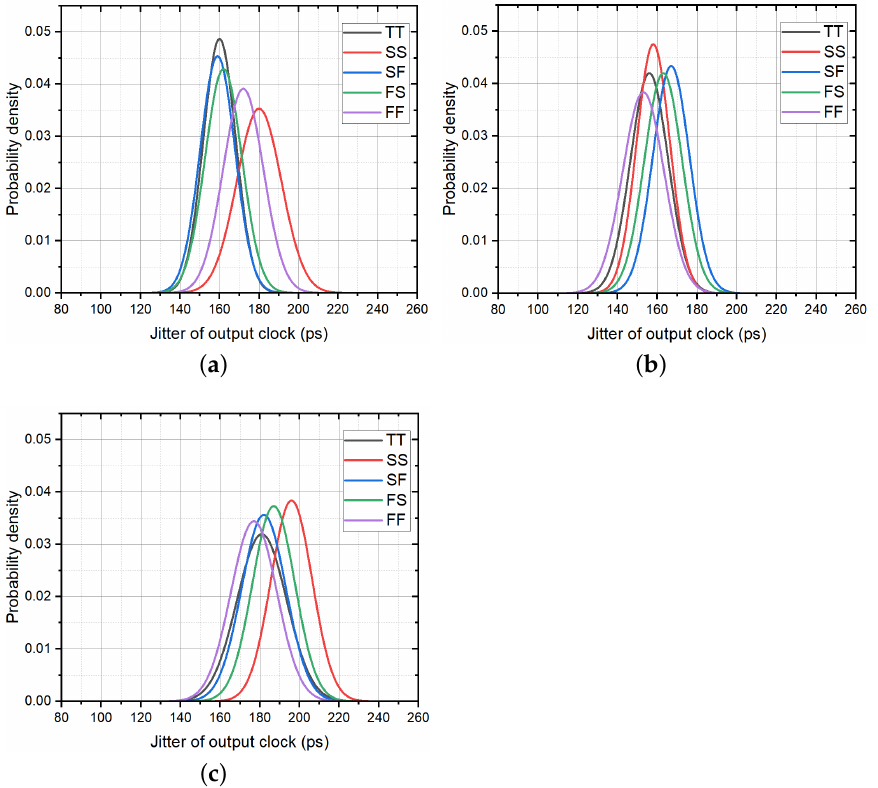
Figure 17. Graphic results of Monte Carlo simulation on the proposed clock multiplier (50 iterations with relative variation ± 8% of the nominal device values). ( a ) Distribution of output clock jitter at 27 ◦ C; ( b ) Distribution of output clock jitter at − 20 ◦ C; ( c ) Distribution of output clock jitter at 85 ◦